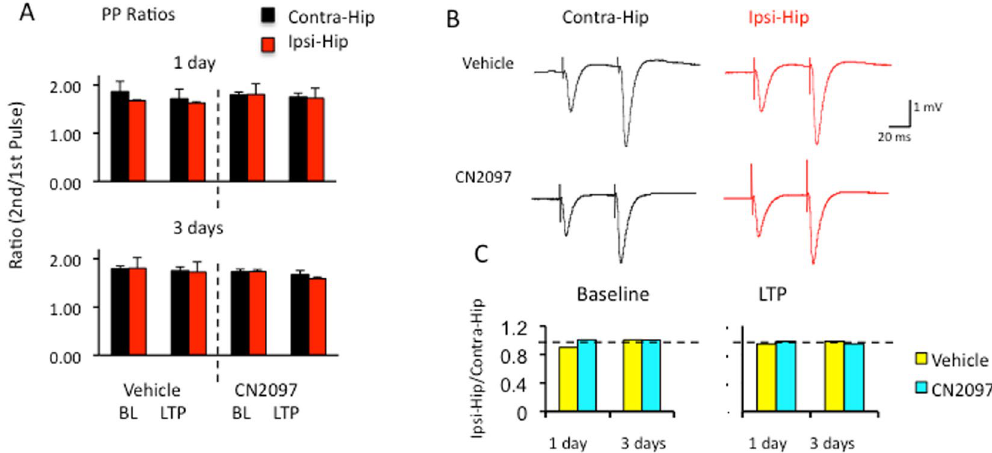
Figure 4. Presynaptic mechanisms are not involved in TBI-dependent LTP impairment and CN2097-induced LTP restoration. ( A ) Paired pulse ratios (PPRs) for vehicle- and CN2097-treated rats in both hemispheres at 1d (top) and 3 d (bottom) after TBI at baseline (BL) and after LTP induction (LTP). ( B ) Examples of fEPSP traces representing averages of 10 responses at baseline in the contralateral (Contra-Hip, black) and ipsilateral (Ipsi-Hip, red) hippocampi in vehicle- (top) and CN2097-treated (bottom) rats at 3 d following TBI. Results indicate no differences between groups. ( C ) Interhemisphere ratios (Ipsi/Contra) of PPR results at baseline (left) and after LTP induction (right) for vehicle- (yellow) and CN2097-treated (blue) rats. Neither TBI nor CN2097 treatment modifies PPRs. Data represent mean ± SEM.